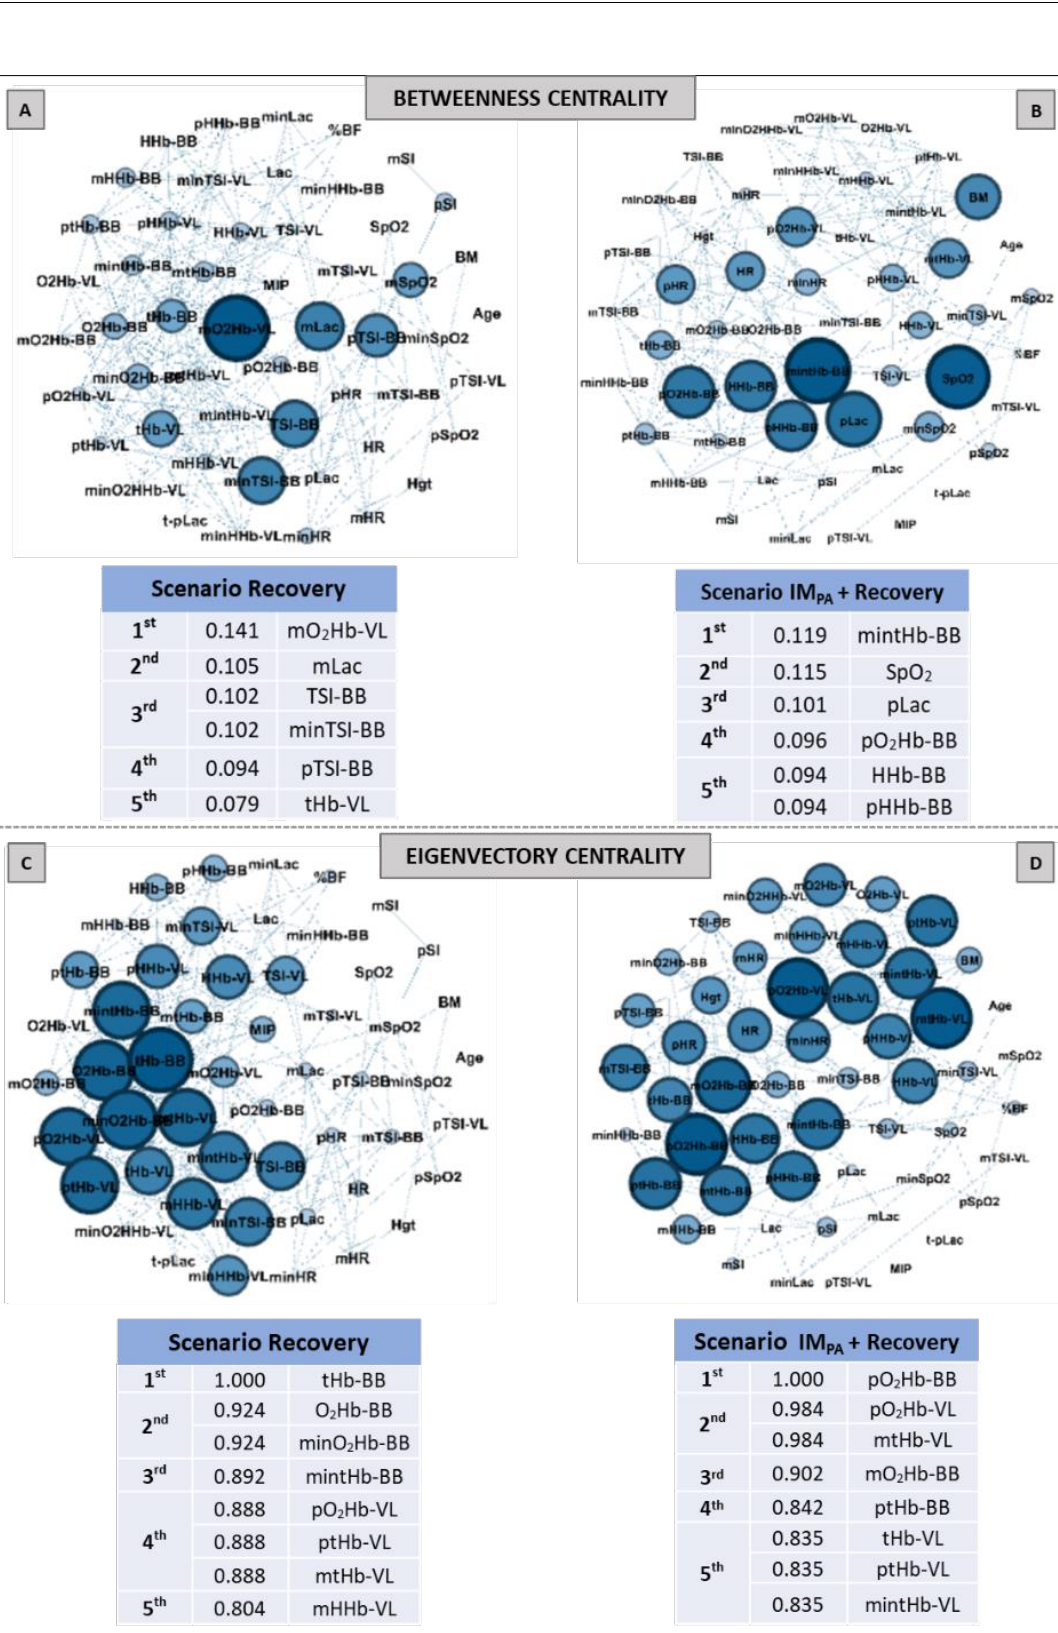
Figure 6. Graphs and top five node results obtained by complex network analysis using Betweenness Centrality ( Panels A,B ) and Eigenvector Centrality ( Panels C,D ) metrics in two recovery scenarios: without inspiratory muscle pre-activation (Scenario Recovery, at Panel A,C ) and with inspiratory muscle pre-activation (Scenario IM PA + Recovery, at Panels B,D ). Graph visualizations were done using Gephi software (version 0.9.2, Paris, France). Legend : AO30 = all-out 30 s, IM PA = inspiratory muscle pre-activation, Hgt = height, BM = body mass, %BF = percentage of body fat, MIP = maximal inspiratory pressure, SI = global strength index of inspiratory muscles, Lac = blood lac- tate, HR = heart rate, SpO 2 = arterial oxygen saturation, O 2 Hb = oxyhemoglobin relative